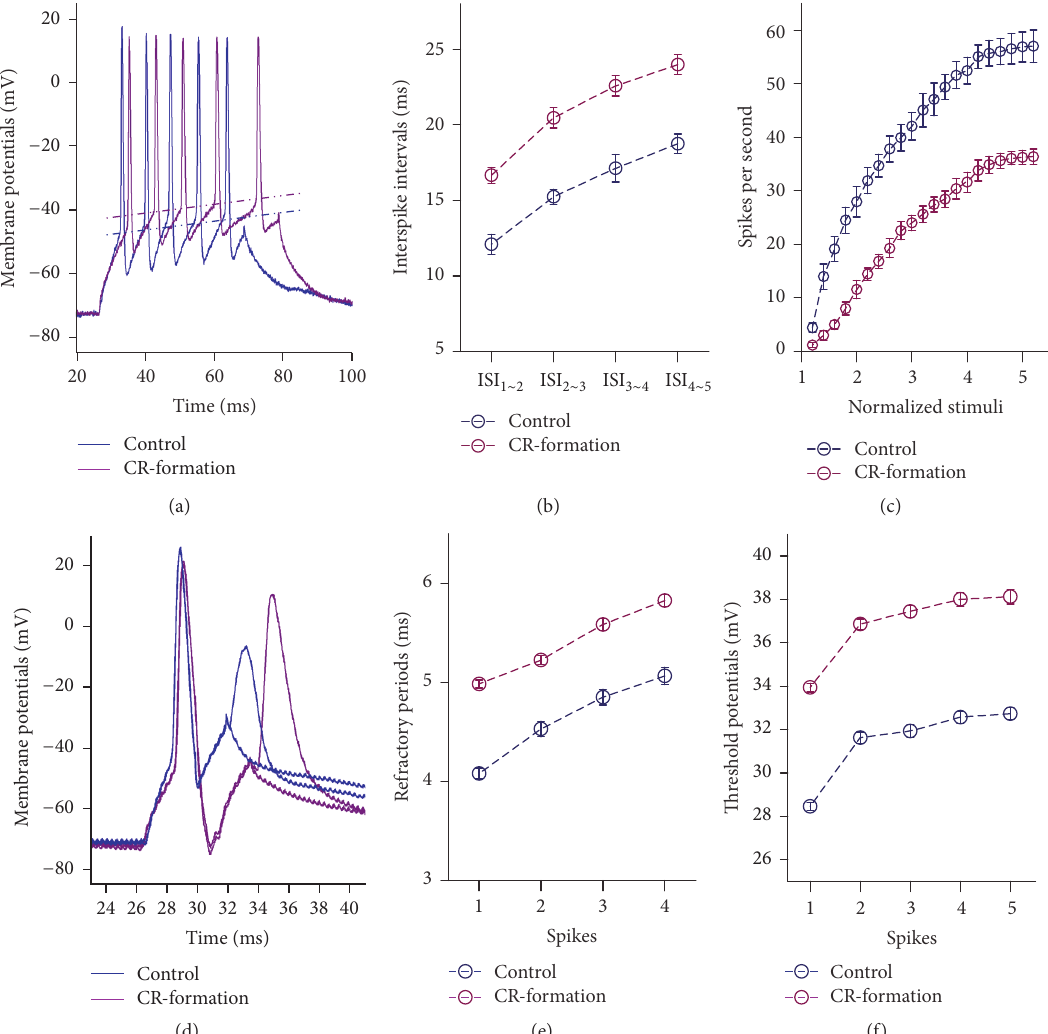
Figure 8: The ability to encode spikes in barrel cortical GABAergic neurons decreases after pairing WS and OS. Spikes were induced by depolarizationpulsesundervoltage-clamprecordingontheGABAergicneuronsincorticalslices.(a)illustratesdepolarization-inducedspikes on the neurons from controls (dark-blue trace) and CR-formation (dark-red). (b) shows interspike intervals for spikes 1 ∼ 2 to spikes 4 ∼ 5 from controls (dark-blue symbols, 𝑛 = 21 ) and CR-formation (dark-red symbols, 𝑛 = 22 ). (c) illustrates spikes per second versus normalized stimuli (input-output) from control (dark-blue symbol, 𝑛 = 21 ) and CR-formation (dark-red, 𝑛 = 22 ). (d) shows the measurement of spike refractory periods on the neurons from control (dark-blue trace) and CR-formation (dark-red). (e) shows refractory periods versus spikes 1 to 4 from controls (dark-blue symbols, 𝑛 = 21 ) and CR-formation mice (dark-red symbols, 𝑛 = 22 ). (f) illustrates threshold potentials versus spikes 1 to 5 from controls (dark-blue symbols, 𝑛 = 21 ) and CR-formation (dark-red symbols, 𝑛 = 22 ).